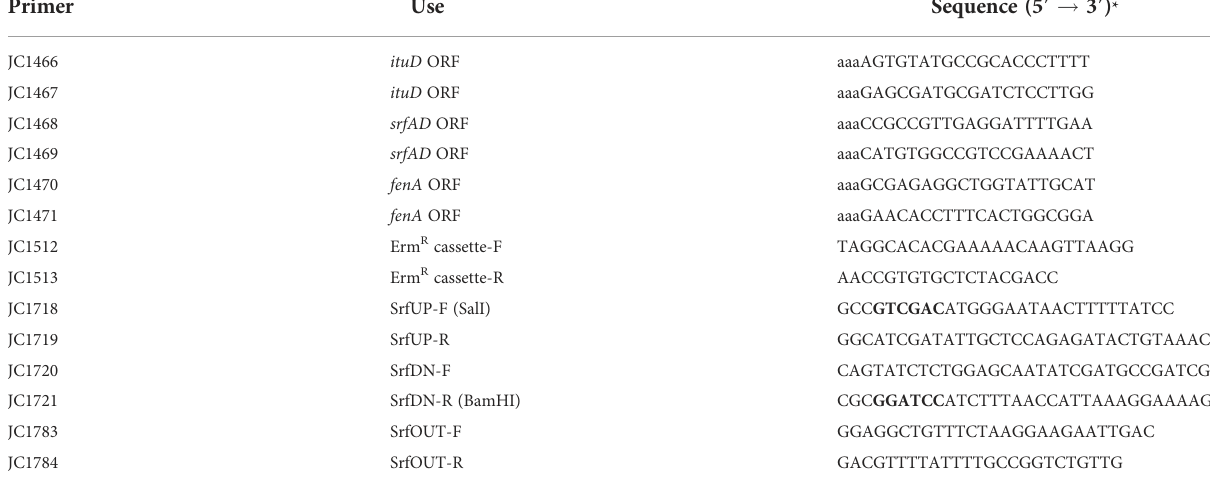
*Bold letters represent restriction sites used for the cloning; underlined letters represent overlapping PCR